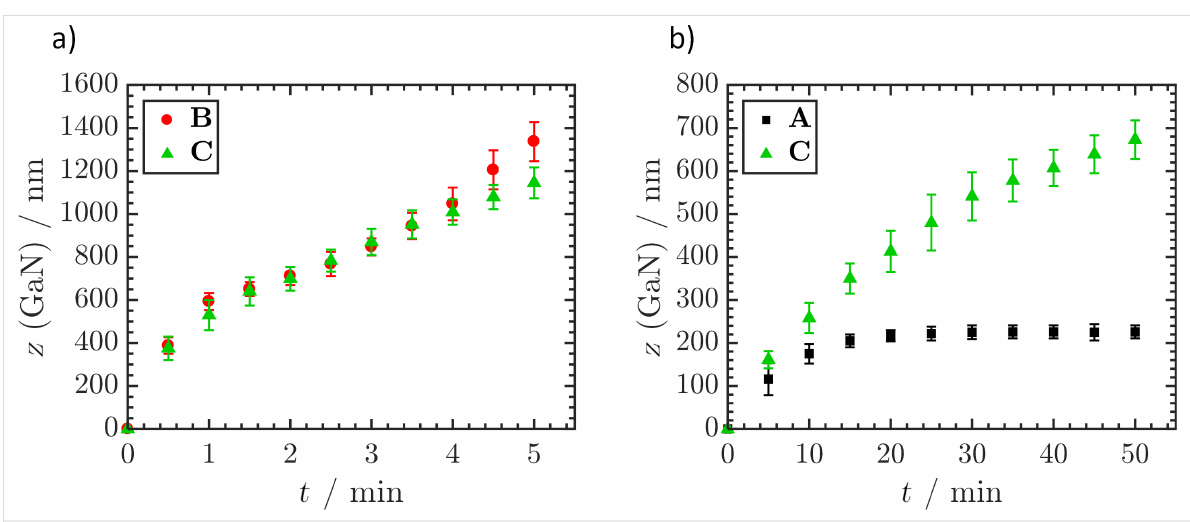
Figure 5: SEM images of A after 60 min etching in 30 wt % KOH solution at RT (a), and of B after 2 min etching in 30 wt % KOH solution at 80 °C (b). Images were recorded at an angle of 60°.